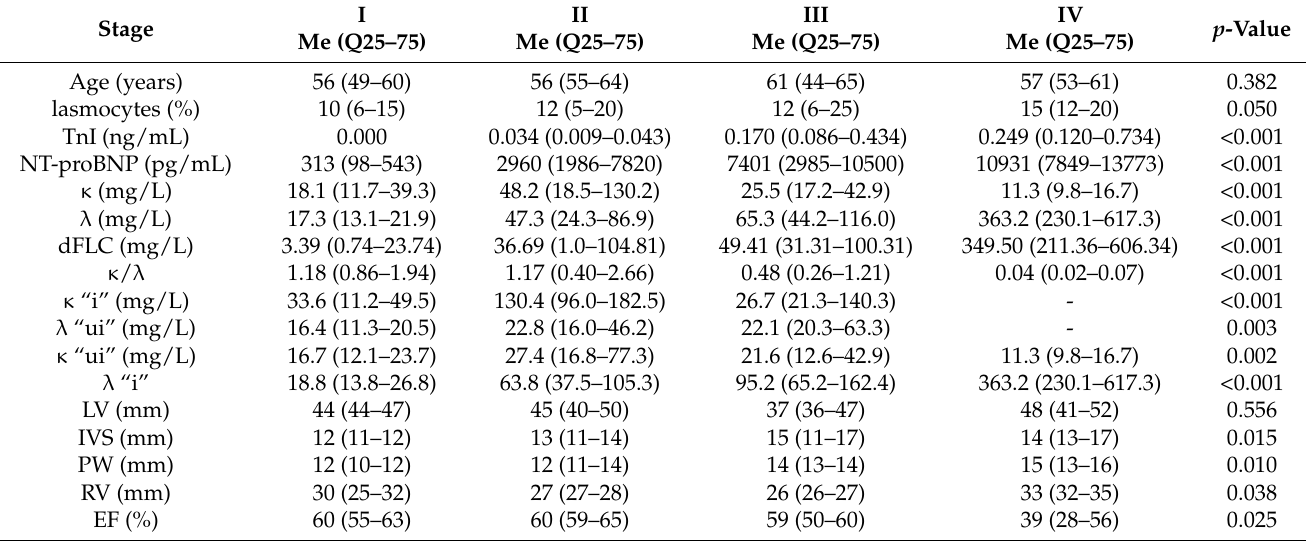
Table 6. Comparative analysis of study groups based on the current Kumar et al. prognosis classification (Stages I–IV).